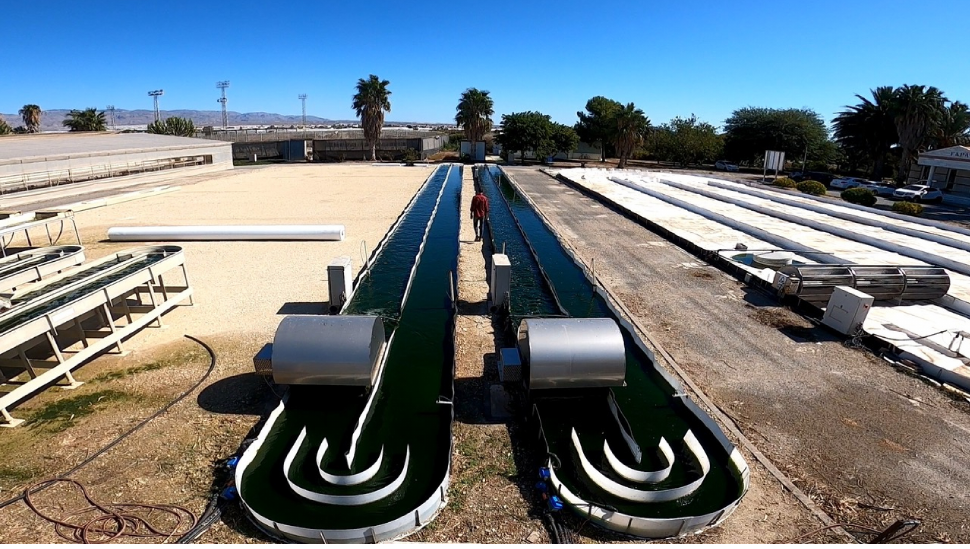
Figure 1. Raceway photobiorreactors modeled in this